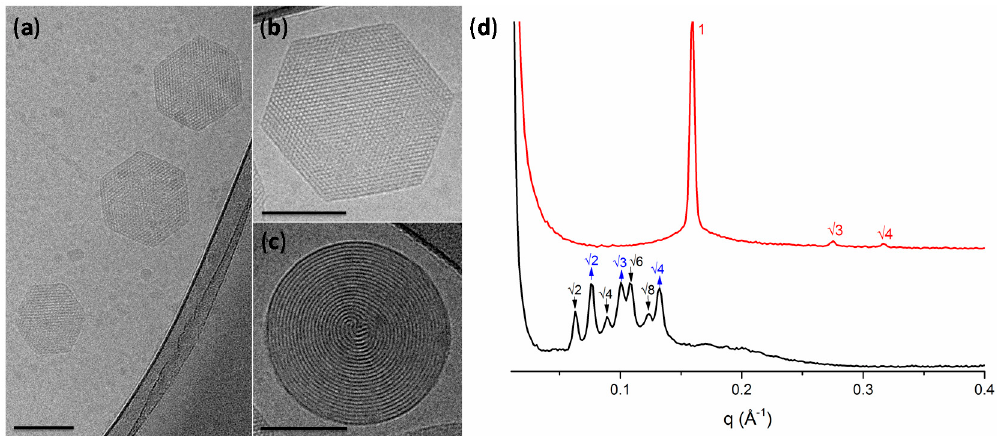
Figure 2. ( a – c ) Representative cryo-electron microscopy micrographs of hexosomes (all scale bars represent 100 nm); ( d ) small-angle X-ray scattering profiles of the lipid-based liquid crystals without (black) and with undecylenic acid (red). The cubic phases are indicated by arrows: black, down arrows show the reflections of the Im3m cubic phase; blue, up arrows show the reflections of the Pn3m cubic phase. The reflections are annotated above the Bragg peaks.